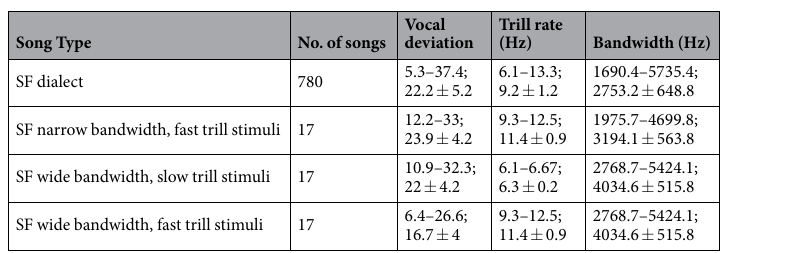
Table 1. A comparison of San Francisco songs and experimental stimuli for vocal deviation, trill rate, and bandwidth (range; mean ± SD). Ranges for San Francisco (SF) dialect are from Phillips & Derryberry